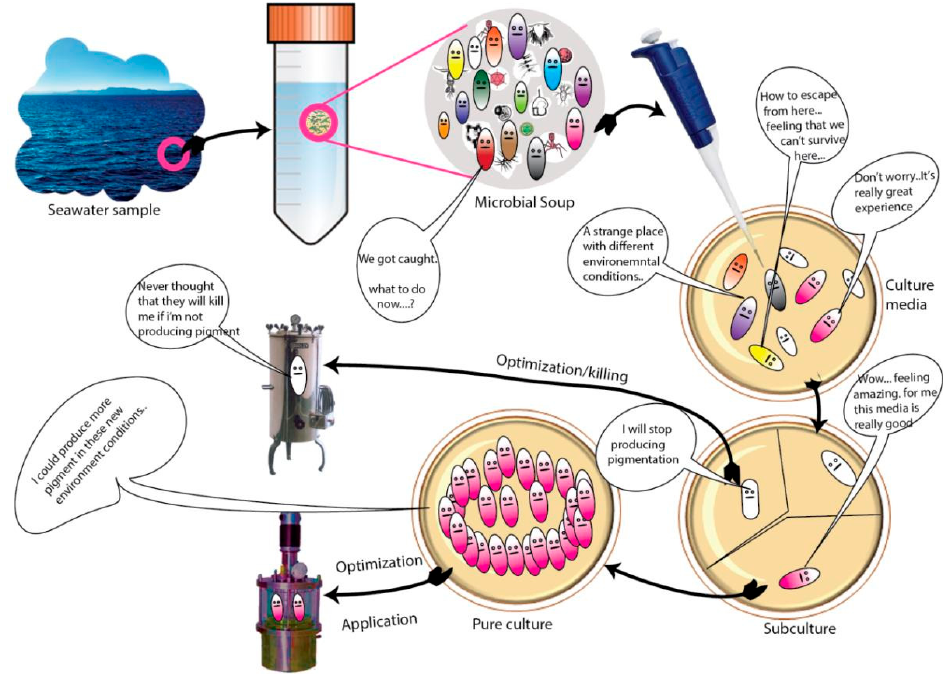
Figure 3. An illustration showing the feelings of microbes.